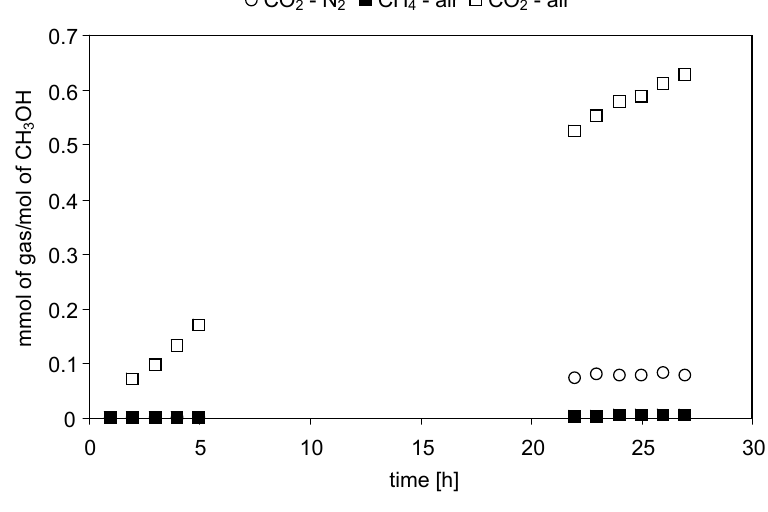
Figure 2. Evolution of CH 4 and CO 2 in time of irradiation during the photocatalytic degradation of CH 3 OH. Photocatalyst loading: 1g/dm 3 ; CH 3 OH concentration: 1 mol/dm 3 ; solution pH: 6.3; t = 25